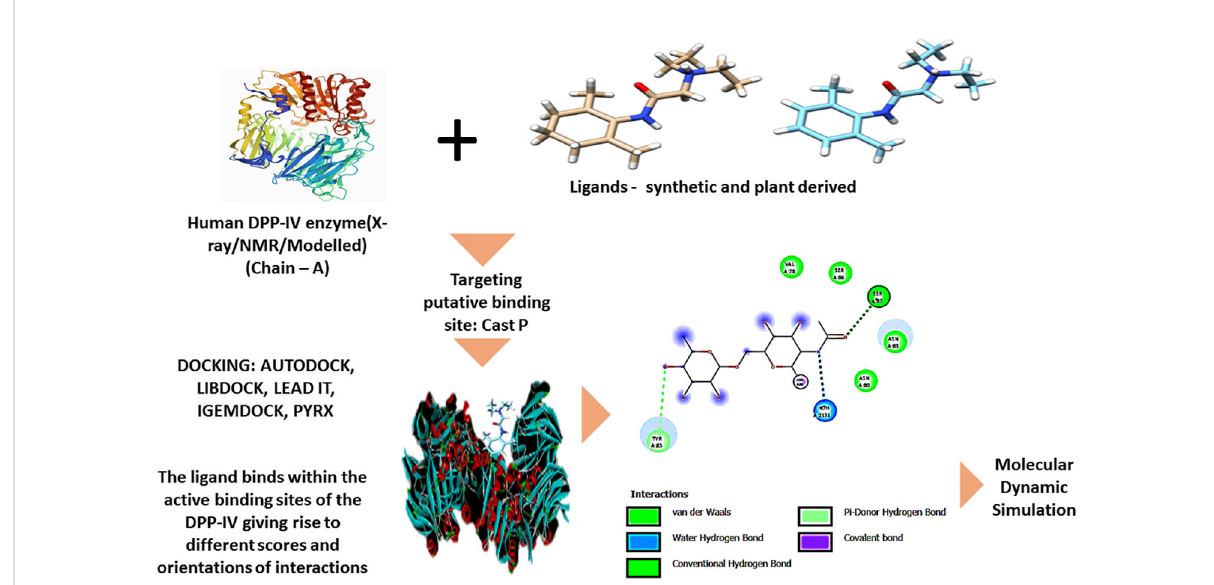
FIGURE 5 General mechanism of molecular docking. With a view to check the inhibition ef fi cacy of different phytocompounds against the dipeptidyl peptidase (DPP)-IV putative binding site, in silico analysis can be performed by exploring various software, and in accordance with the same, different binding scores and orientations can be known, which are further projected towards molecular dynamics simulation. The ribbon structure of the human DPP-IV and the molecular structure of the ligand were downloaded from the protein data bank of PubMed and PubChem, respectively. The molecular interaction fi gure is recited after Kim et al. (2018) (47) under creative common license